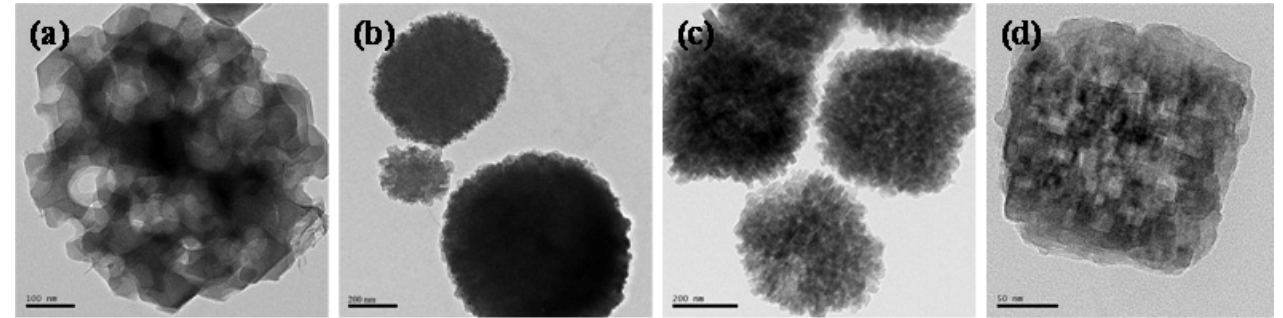
Figure 6. Hierarchical porous zeolites: (a) mesoporous silicalite-1 synthesized with nano CaCO templates. Adapted from Reference [161]; (b) mesoporous ZSM-5 synthesized with 3 starch templates. Adapted from Reference [162]; (c) mesoporous ZSM-11 synthesized with polyvinyl butyral gel templates. Adapted from Reference [163]; (d) mesoporous Beta zeolite synthesized with polyvinyl butyral gel templates. Adapted from Reference